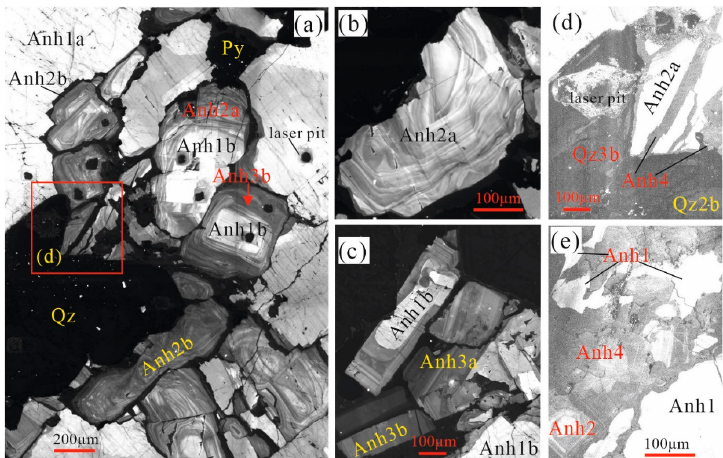
Figure 7. Cathodoluminescence (CL) microtextures of vein anhydrite at the Tongchang porphyry Cu deposit. ( a ) The first generation of anhydrite (Anh1), rimed and surrounded by CL-oscillatory Anh2, coexisting with pyrite and quartz; ( b ) Anh2a showing “wavy” oscillatory zoning; ( c ) A cluster of euhedral Anh3a and Anh3b grains, with Anh3a showing oscillatory zoning, whereas Anh3b showed homogeneous CL; ( d , e ) CL-dark Anh4 cemented fragments of earlier anhydrite grains including Anh1 and Anh2.